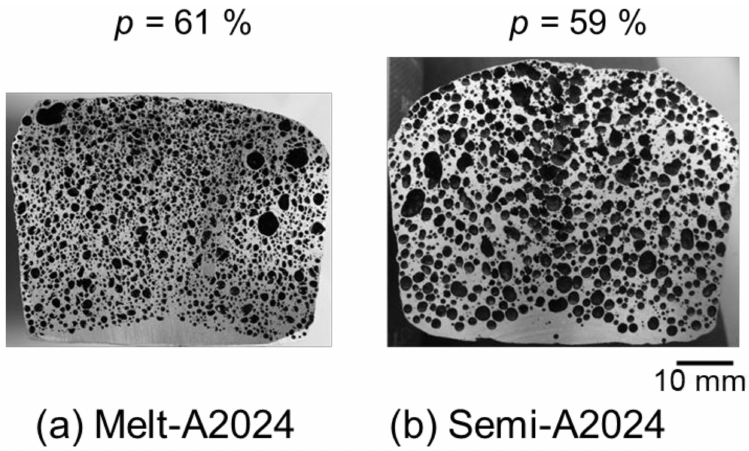
Figure 4. Cross sections of samples: ( a ) Melt-A2024; ( b )